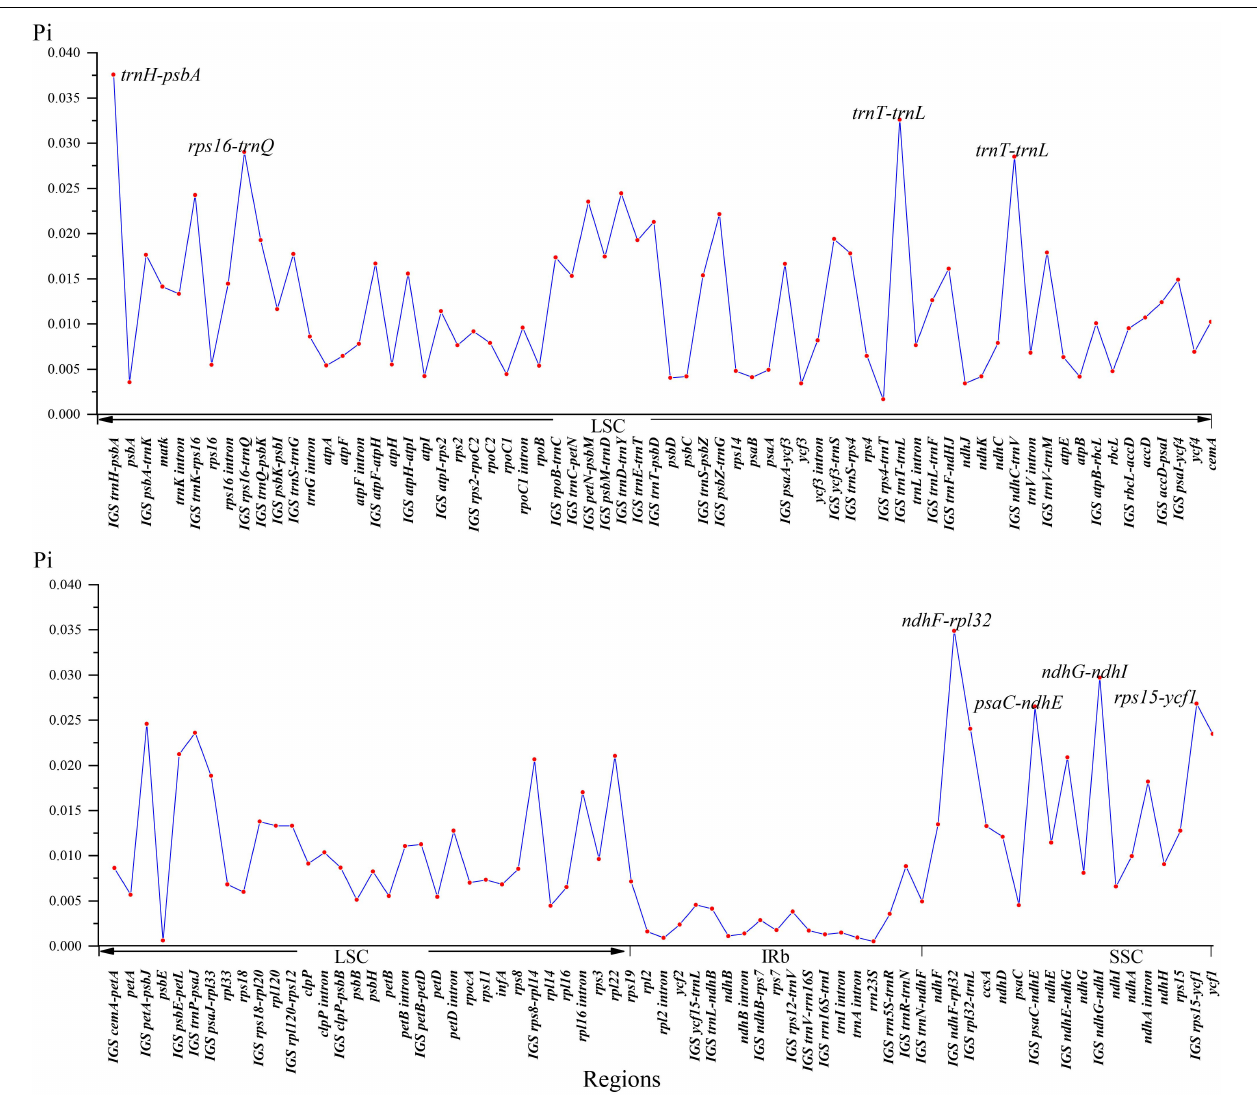
FIGURE 4 | Nucleotide diversity ( Pi ) values of 26 Nandinoideae plastome